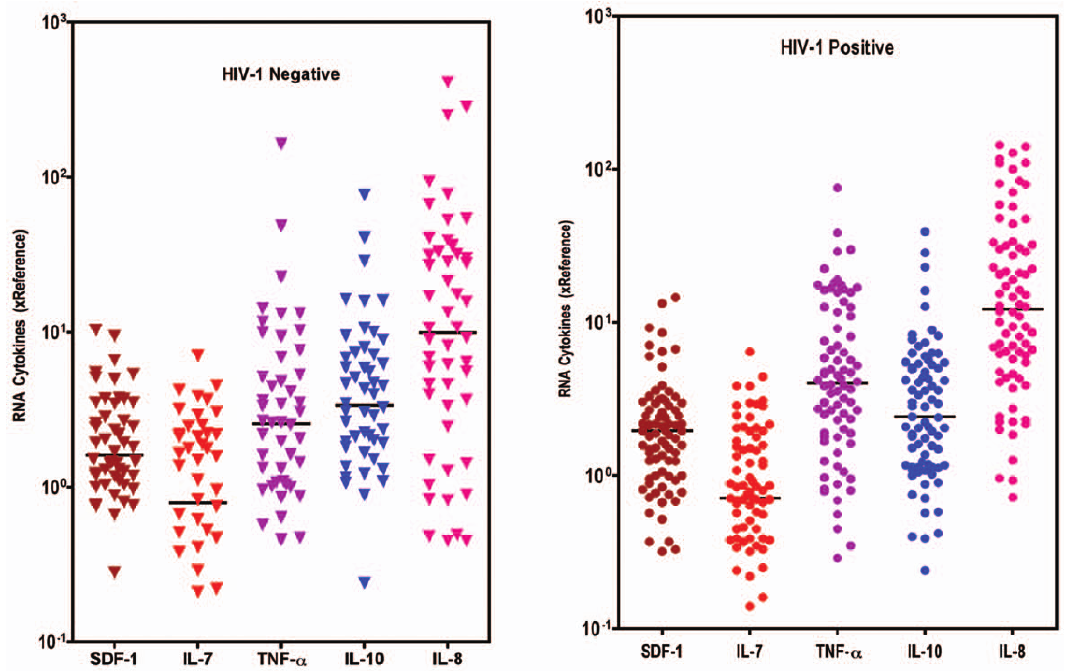
Figure 1. Levels of cytokine mRNA expressed in the placenta of HIV-1 negative (left panel) and positive (right panel) women. Cytokine mRNA were extracted from Cryo-preserved placenta fragments of HIV-1 negative and positive women. Reverse transcribed cytokine mRNA were quantified by Real Time PCR. Results were normalized to references values of a HIV-1 negative placenta (Ref). Each dot represents one individual placenta and the horizontal bar the median value. A total number of 50 placentas for HIV-1 negative and 80 for HIV-1 positive women were tested for each cytokine. Comparison between the 2 groups was performed through Mann-Whitney test. doi:10.1371/journal.pone.0008114.g001 PLoS ONE |